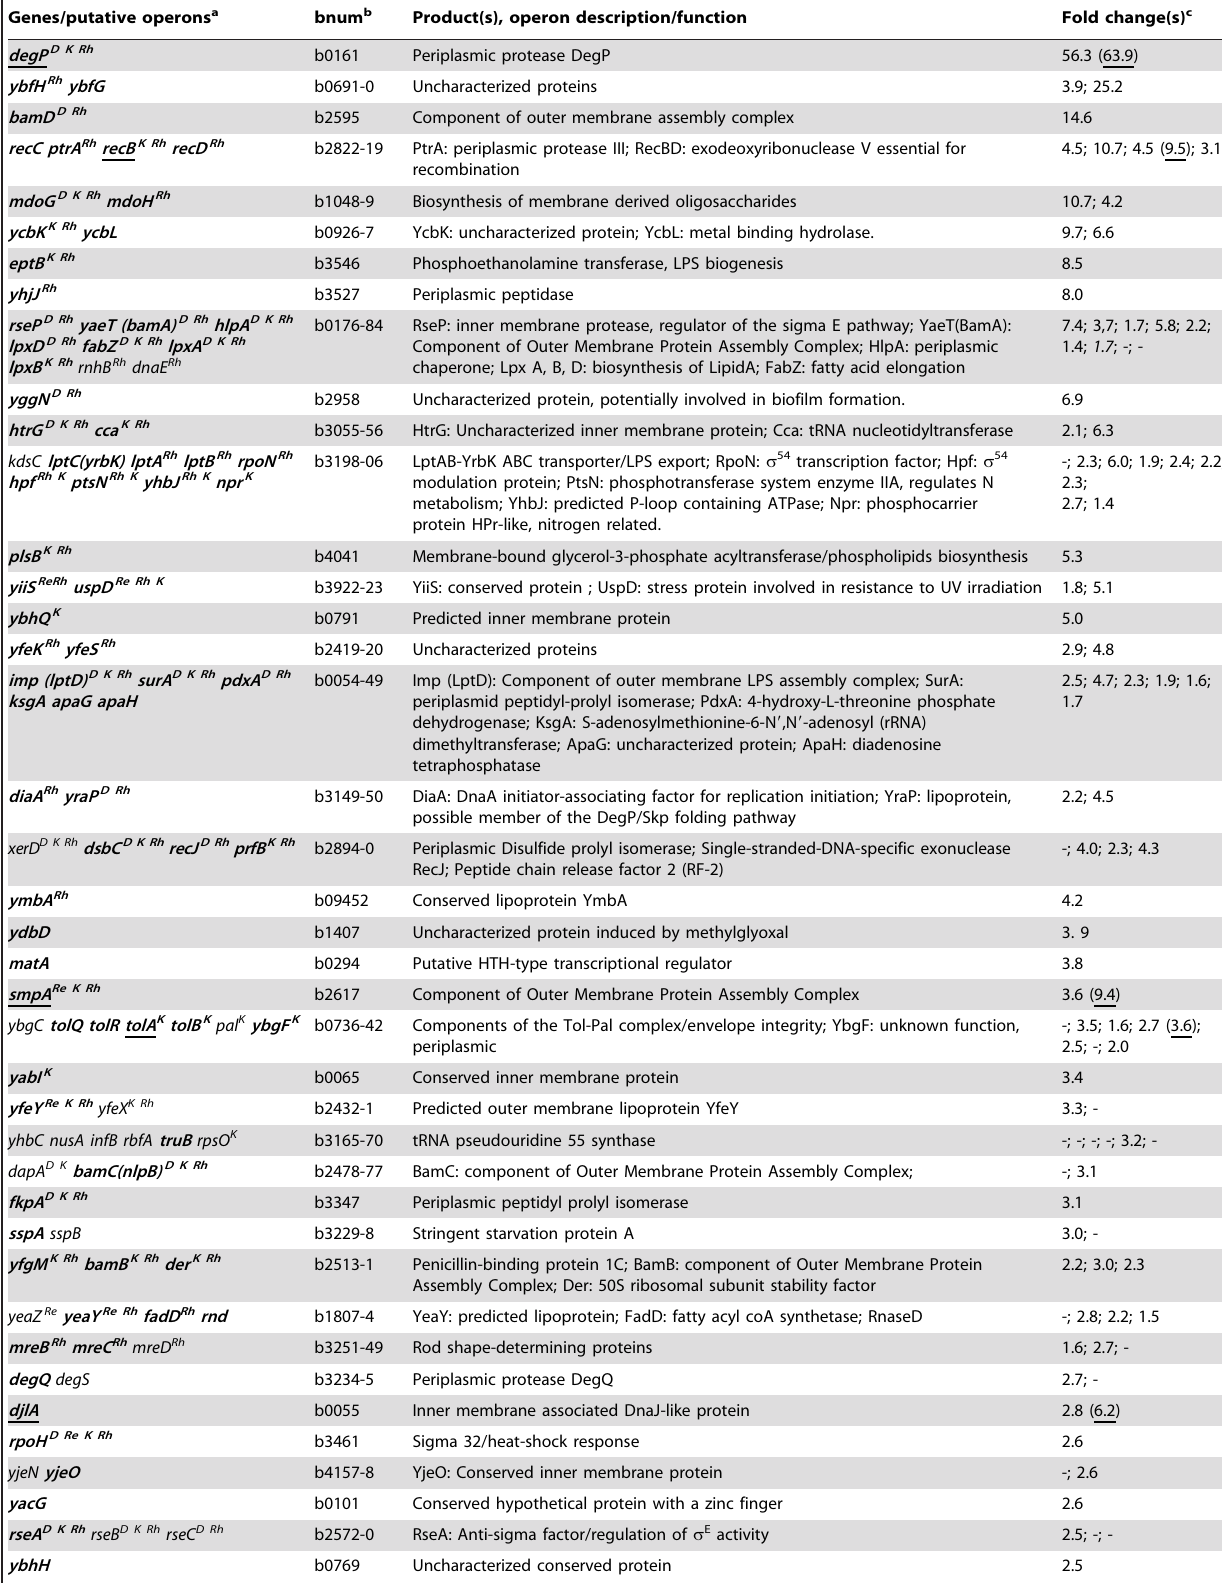
Table 2. Genes whose expression is significantly modulated by s E